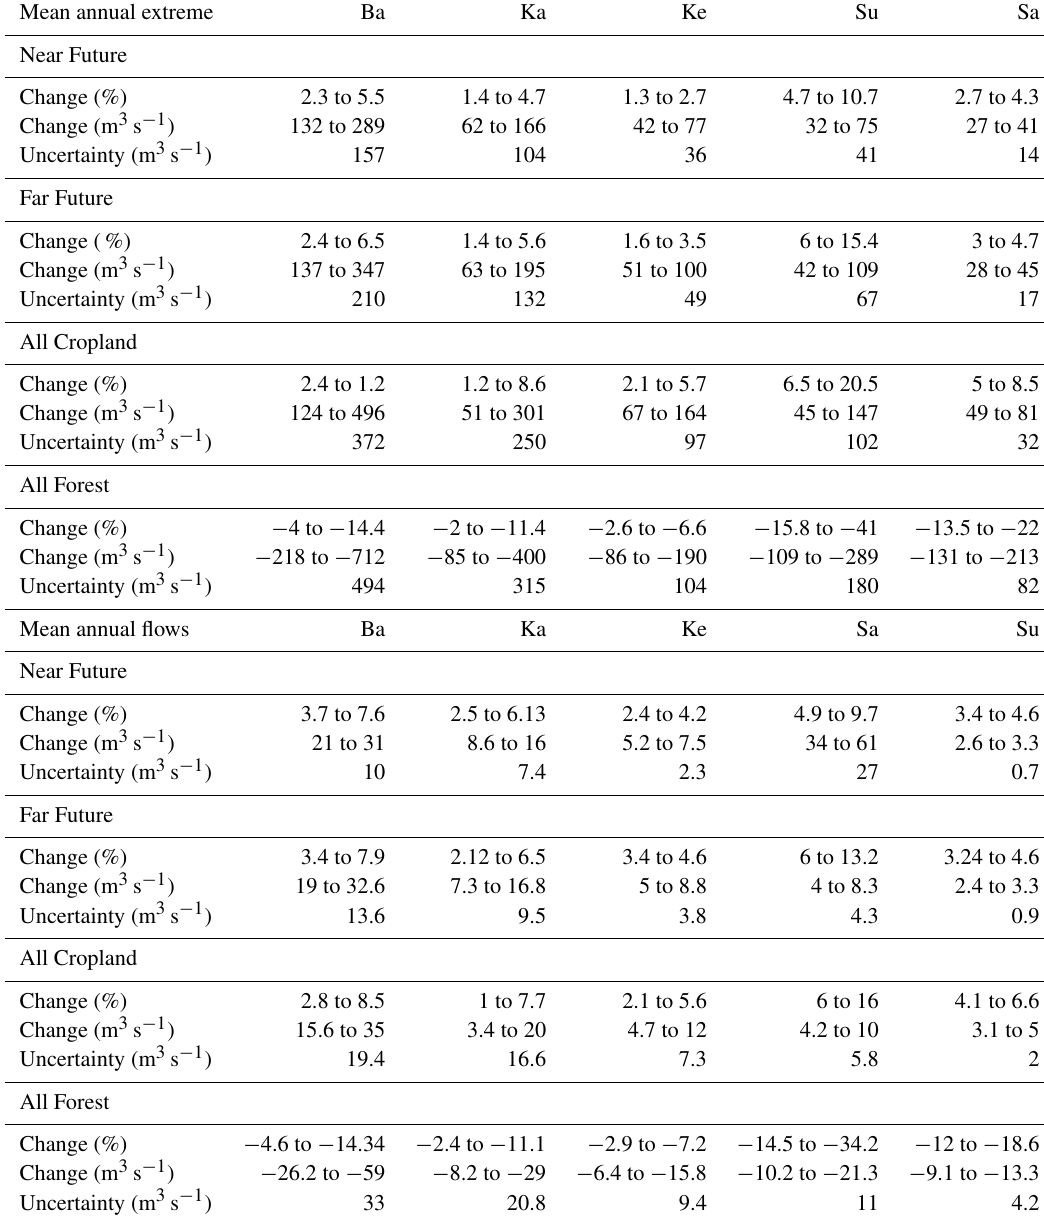
Table 4. Ranges of percent change, change in flows, and uncertainty (i.e., difference between max and min predicted flow) in extreme and mean annual flows in all the scenarios with respect to the baseline